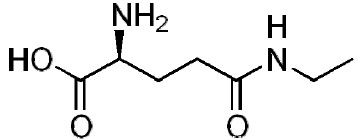
Figure 1. Chemical structure of L